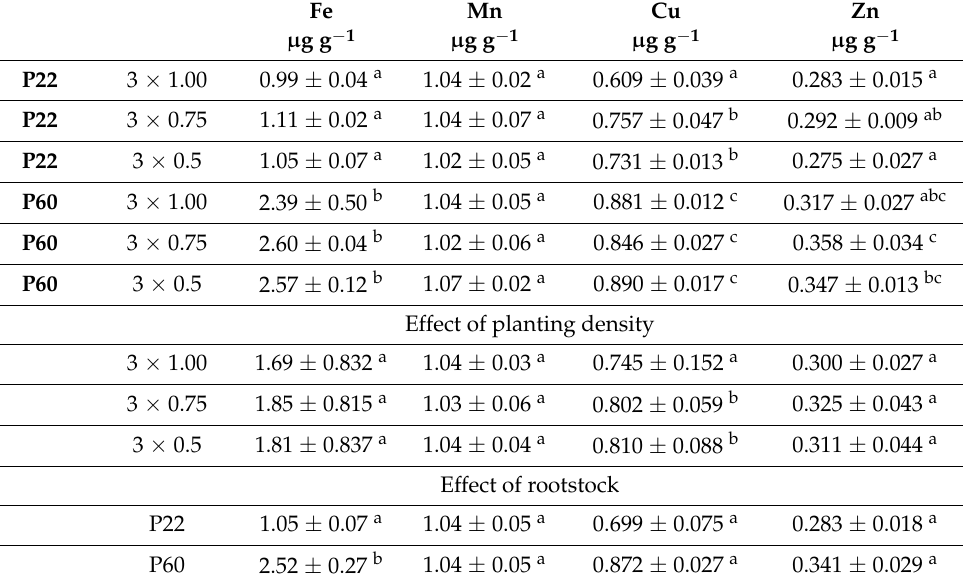
Table 3. The effect of planting distances and rootstock on minor elements in apple fruits. The mean value (n = 3 * 3 = 9) ± standard deviation is presented. The data were processed using a two-way analysis of variance (ANOVA), the Tukey (HSD) test at the confidence level p = 0.05. The different letters in blocks indicate significant